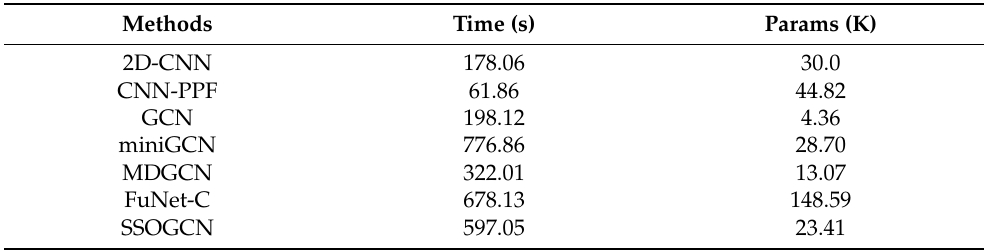
Table 9. Run time comparison and parameter number comparison of depth model in the Indian Pines data